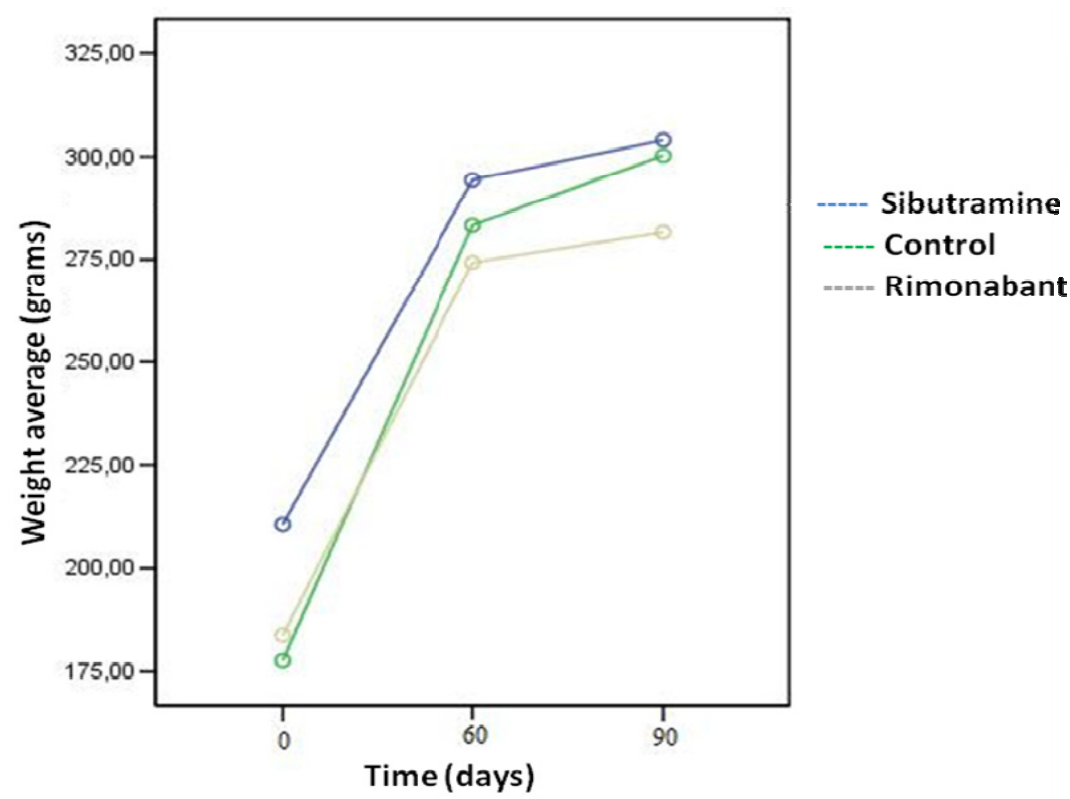
FIGURE 1 - Weight average comparison of three groups in hypercaloric diet on set, on set of drugs and at the end of